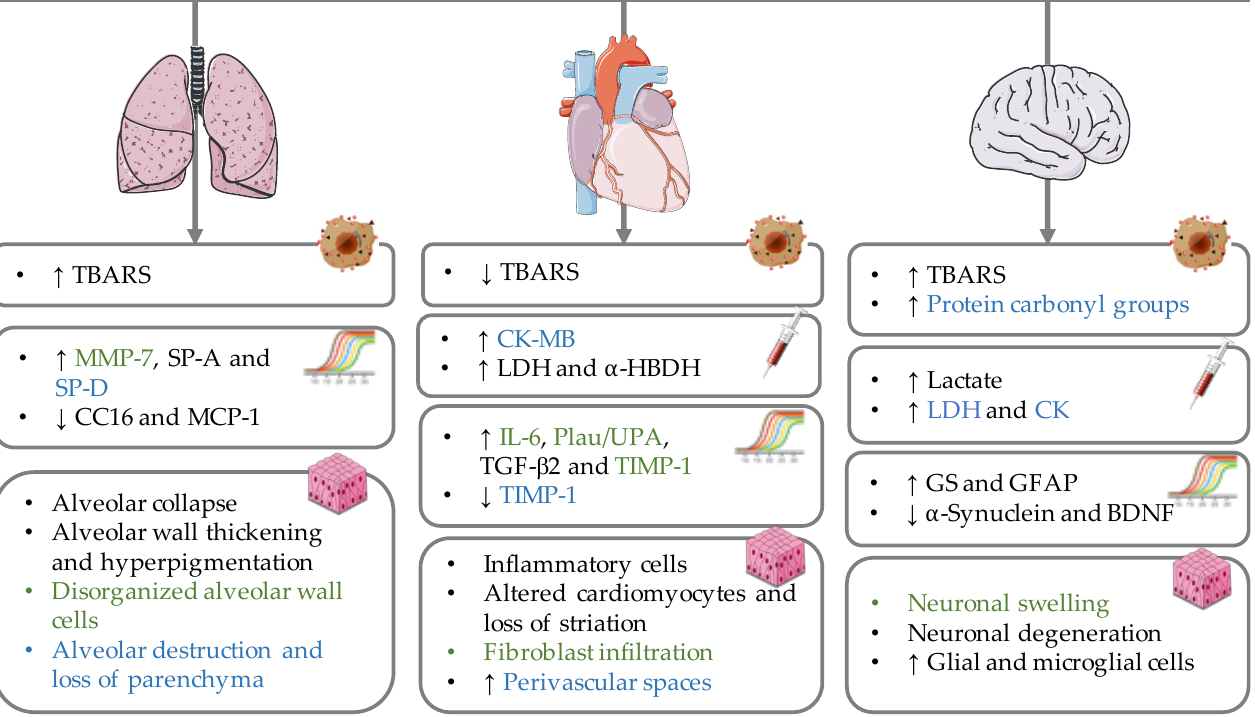
Figure 9. Schematic representation of the pulmonary, cardiac, and brain cortex effects of a 14-day exposure of Wistar rats to clinically relevant doses of tramadol or tapentadol, assessed at the molecular, oxidative stress, metabolic and histological levels. α -HBDH: α -hydroxybutyrate dehydrogenase; BDNF: brain-derived neurotrophic factor; CC16: Clara cell protein-16; CK-MB: creatine kinase muscle brain isoform; CK: creatine kinase; GFAP: glial fibrillary acidic protein; GS: glutamine synthetase; IL-6: interleukin-6; LDH: lactate dehydrogenase; MCP-1: monocyte chemoattractant protein-1; MMP-7: matrix metalloproteinase-7; Plau/UPA: plasminogen activator, urokinase; SP-A: pulmonary surfactant protein A; SP-D: pulmonary surfactant protein D; TBARS: thiobarbituric acid reactive substances; TGF- β 2: transforming growth factor- β 2; TIMP-1: tissue inhibitor of